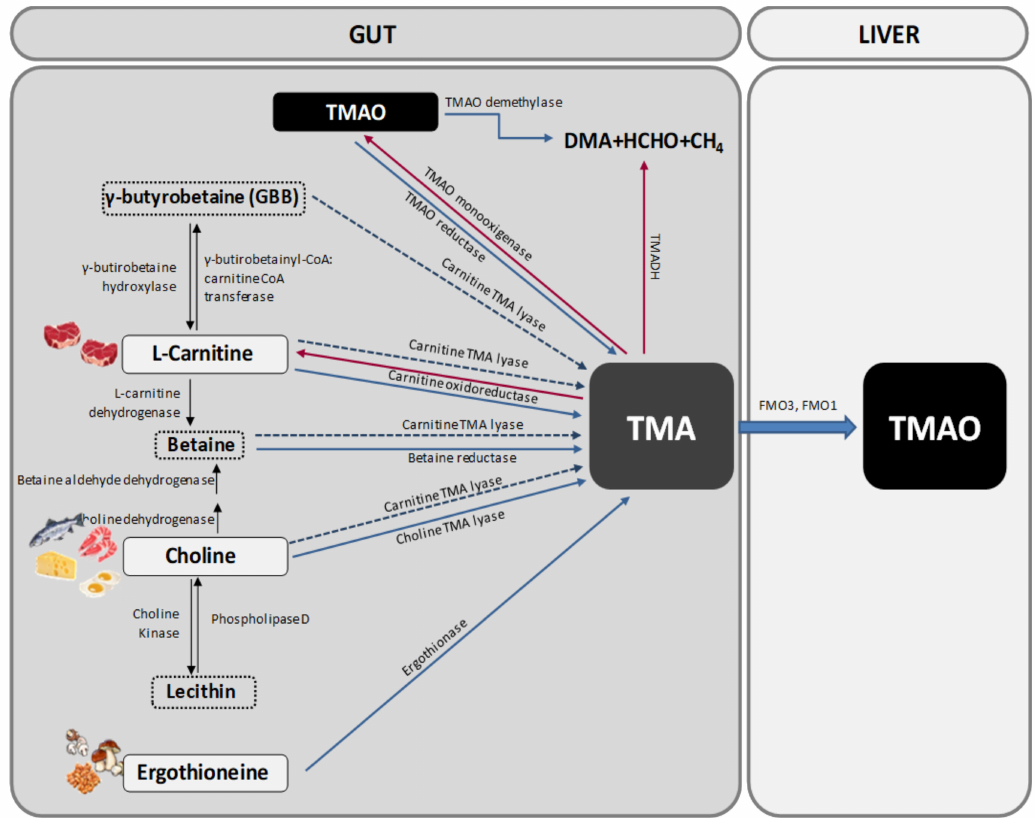
Figure 1. Pathways for trimethylamine N-oxide (TMAO) formation. Trimethylamine (TMA) is